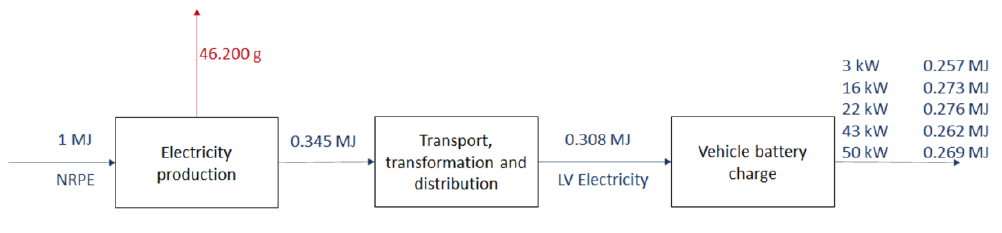
Figure 8. Well-to-tank analysis of electricity considering several charging devices.